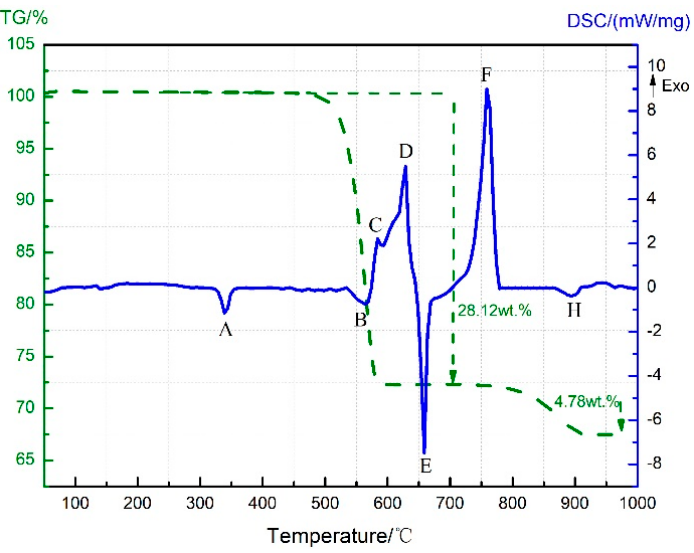
Figure 11. TG-DSC curve of PTFE/Al/MnO 2 .